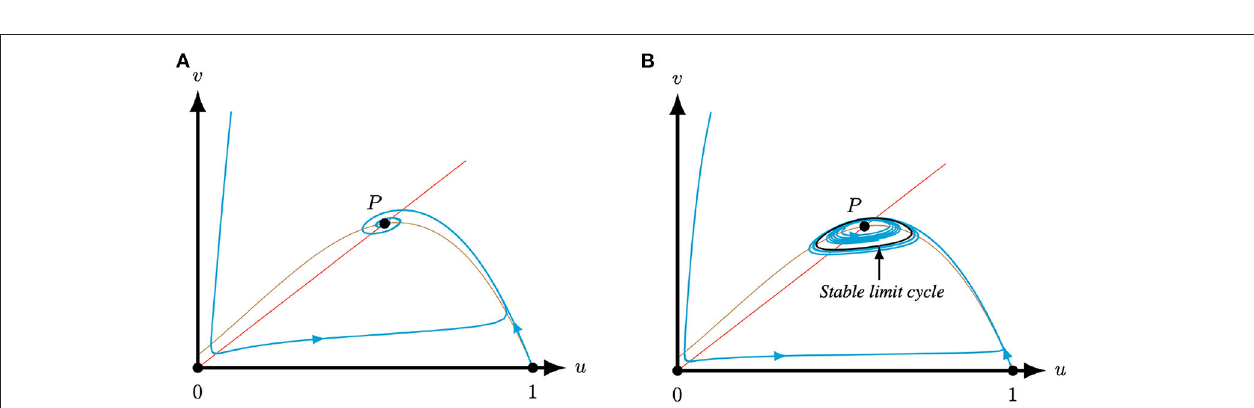
FIGURE 2 | Diagram of the horizontal blow-up and blow-down in a neighborhood of the origin (0,0). (A) Blow-up. (B) Blow-down.